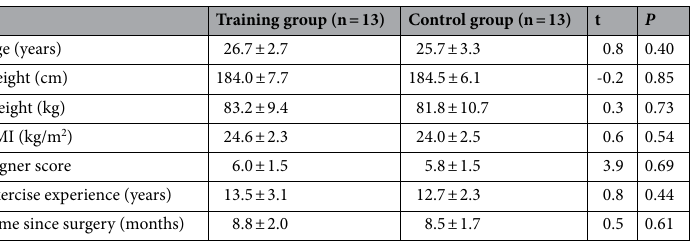
Table 1. Demographic characteristics of participants, reported as mean ± standard